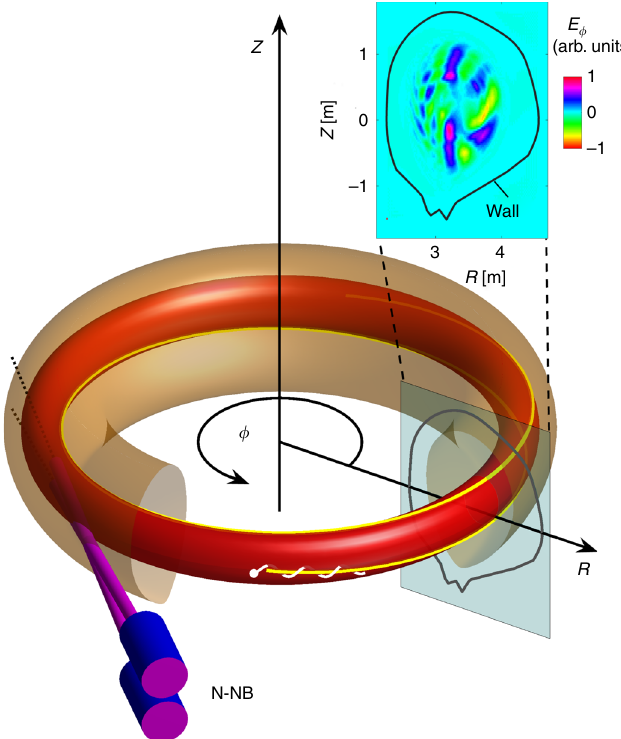
Fig. 2 Geometry of the beam-plasma system. A pair of negative-ion-based neutral beams (N-NB, bottom left) injects neutralised deuterium tangentially into the JT-60U plasma torus, whose boundary is shown in light brown. In the absence of plasma fl uctuations, the ionised 400 keV deuterons (white) gyrate around guiding centre orbits (yellow) that lie on toroidal surfaces such as the one shown in red. Collective resonant interactions between the energetic beam ions and shear Alfvén waves give rise to global fl uctuations such as the example shown at the top right, where we have plotted the spatial structure of the toroidal component of the electric fi eld E ϕ in the poloidal ( R , Z ) plane at a certain toroidal angle ϕ , where R is the radial distance from the torus centre and Z the vertical coordinate. This snapshot of the fl uctuating fi eld E ϕ , which is shown here in arbitrary units (arb. units), was obtained with one of our simulations that are reported in this article. The blue and green regions represent E × B drift vortices with opposite